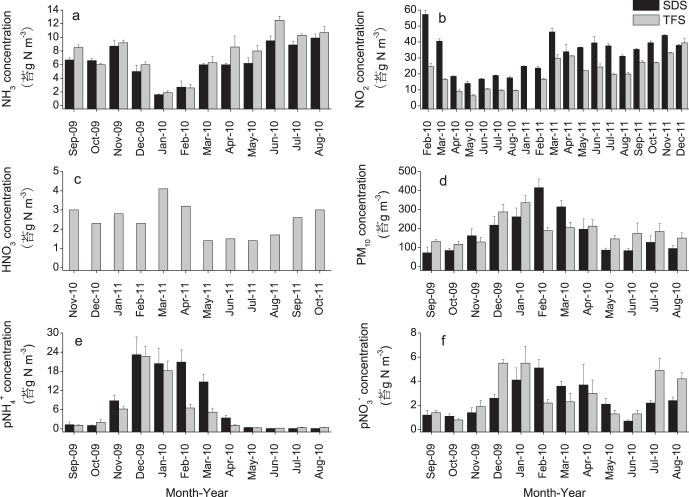
Monthly mean concentrations of (a) NH3, (b) NO2, (c) HNO3, (d) PM10, (e) NH4
+ in PM10 and (f) NO3
− in PM10 at SDS and TFS from September 2009 to August 2010.